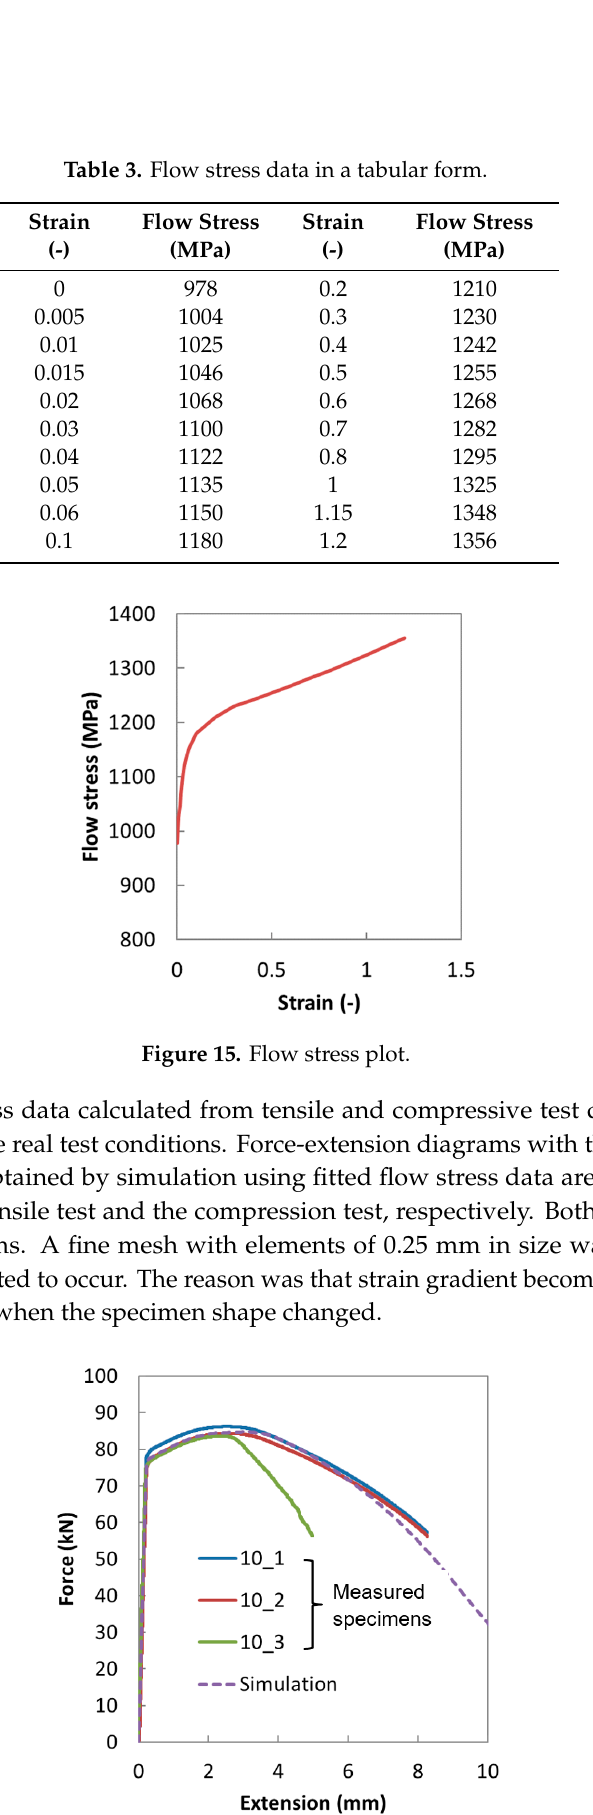
Figure 17. Comparison of compression test curves. 5.2. Identification of Fracture Parameters To determine the critical damage threshold for simulation, experimental fracture data are needed [22]. Fracture is assumed to occur when the force-displacement curve begins to drop. This indicates fracture initiation and the amount of fracture strain. However, since the specimen deforms rapidly during necking, the exact fracture strain value it is very difficult to identify from measured test plots. An estimate of fracture strain can also be obtained by measuring the cross-sectional area of a specimen before and after testing [23]. Using FE simulation of tests, the onset of fracture and the fracture strain can be determined more accurately. The measured and simulated forces are compared in Figure 18 for the notched tensile test, in Figure 19 for the shear test, and in Figure 20. for the plane strain test. These simulations were based on flow stress data from the previous tests. The measured and simulated forces are in very good agreement for all the tests, which means that the flow stress data from smooth tensile and compression tests had been determined accurately. The conditions and constraints used in the simulations of notched tensile test, shear and plane strain tests replicated the actual test conditions. A fine mesh with elements 0.15–0.3 mm in size was used at the mid-length region of the specimen.